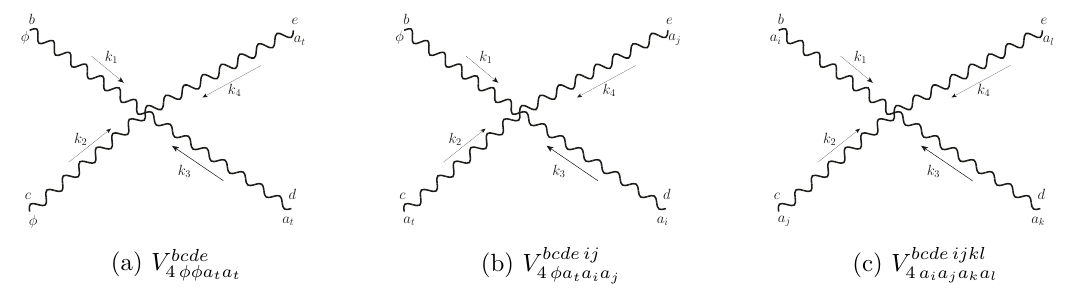
Figure 4 . Four-point